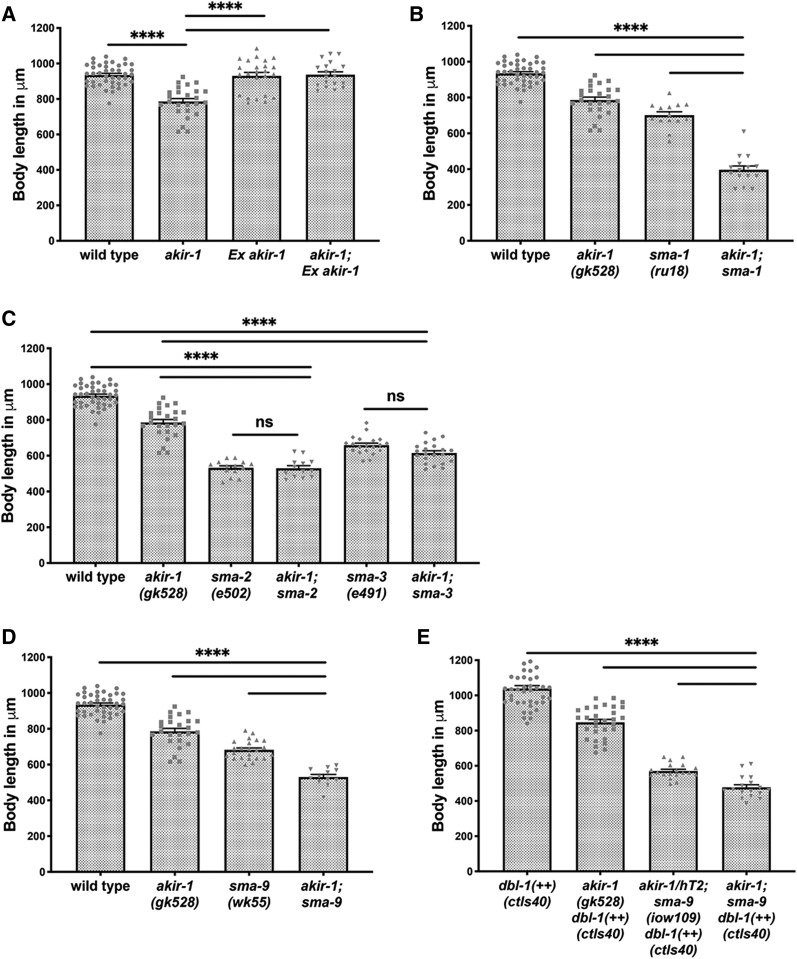
AKIR-1 is a component of the TGFβ pathway and is required for proper C. elegans body length. Body length in wild type, akir-1(gk528) and TGFβ (Sma/Mab) loss-of-function mutants. Quantification of body lengths, individual measurements plotted with mean plus SEM shown. A) Wild type n = 41, akir-1(gk528) n = 25. Overexpression of AKIR-1 via the presence of a wild type akir-1 gene in an extra-chromosomal array results in no significant change in body length (mean 930.6μm, SEM 18.98, n = 24), and the wild type akir-1 gene in the extra-chromosomal array rescues the body length defect when present in akir-1(gk528) animals (n = 19). B) sma-1(ru18) n = 14, is significantly shorter than wild type (P < 0.0001, MW U-test) but not akir-1(gk528). (P = 0.0786, MW U-test). akir-1(gk528);sma-1(ru18) n = 15. C) sma-2(e502) n = 14, akir-1(gk528);sma-2(e502) n = 13. sma-3(e491) n = 20, akir-1(gk528);sma-3(e491) n = 21. D) sma-9(wk55) n = 23, akir-1(gk528);sma-9(wk55) n = 12, E) dbl-1(++) n = 41, akir-1(gk528); dbl-1(++) n = 30, dbl-1(++); akir-1/hT1; sma-9(iow109) n = 19, dbl-1(++); akir-1; sma-9(iow109) n = 17.*** 0.0001 ≤ P < 0.001. For simplicity only statistical analysis compared to double mutant is presented in B-E.